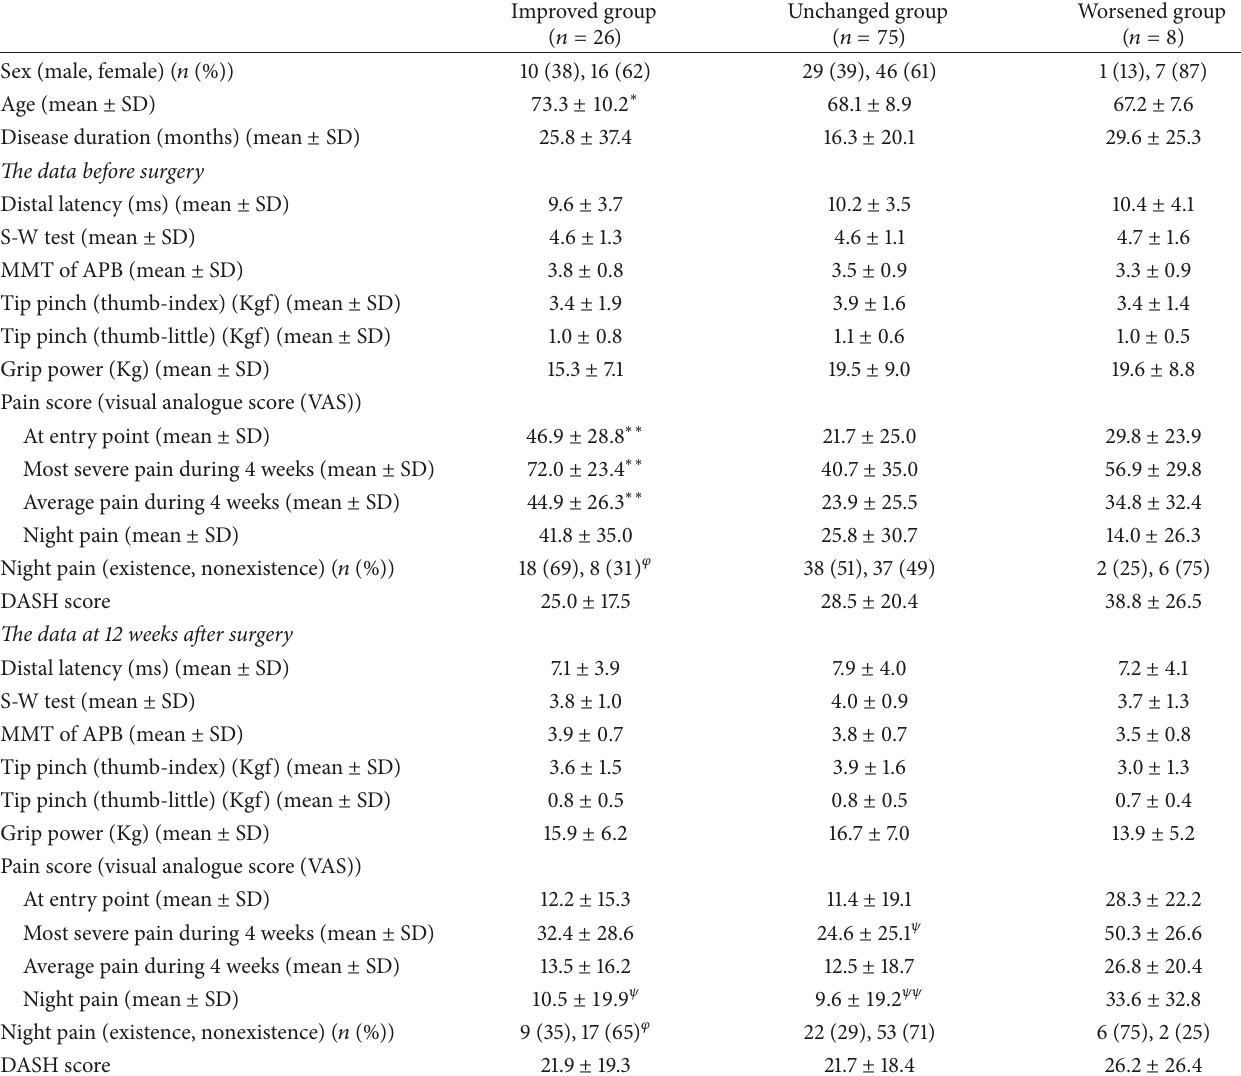
Table 6: A comparison of the Improved, Unchanged, and Worsened groups at 12 weeks after